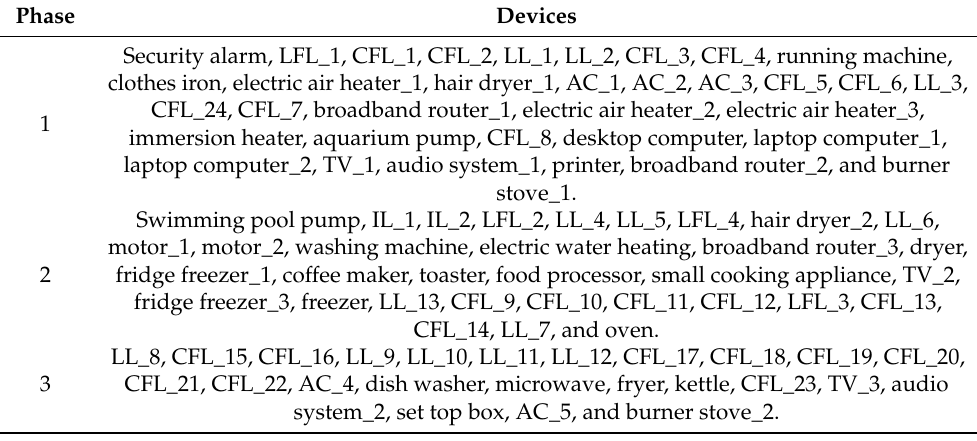
Figure 3. Proposed disaggregation model architecture. Table 1. Description of the devices in the house. LFL: linear fluorescent lamp, CFL: compact fluorescent lamp, LL: LED lamp, AC: air conditioner, TV: television, IL: incandescent